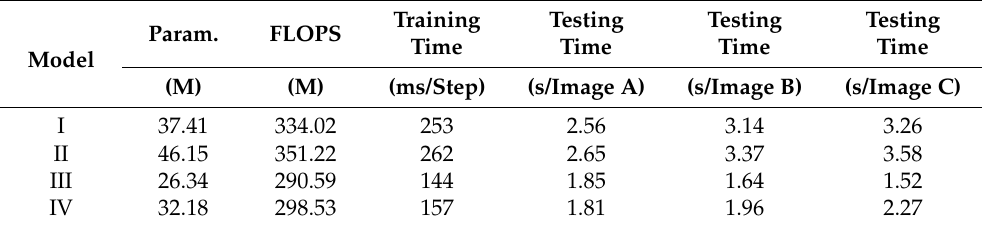
Table 6. Comparison of parameters, floating-point operations per second (FLOPS), and training and testing times of the different